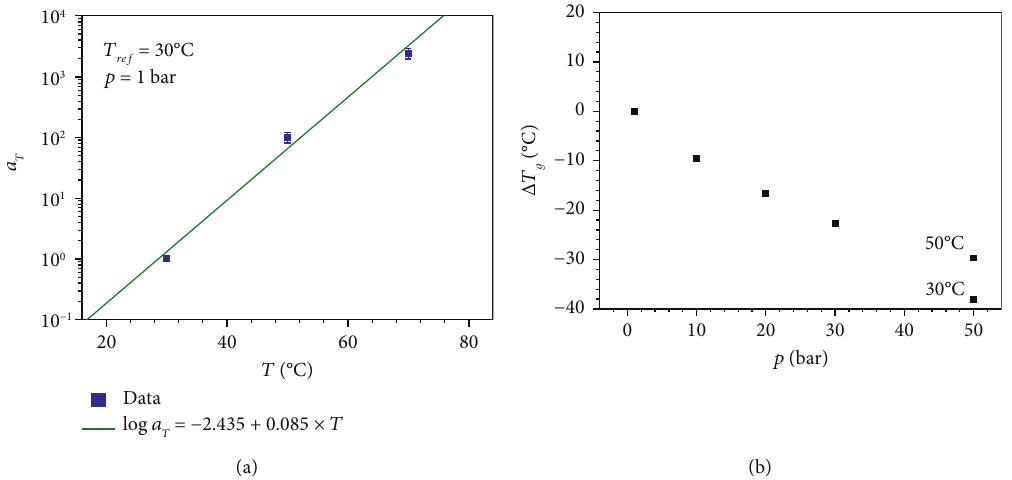
Figure 10: (a) Calculated shift factor a as obtained by tensile creep experiments at 30 ° C and ambient pressure. The result of a linear fi t to T the data is also plotted. (b) Glass transition temperature as a function of applied pressure as determined by analysis of the tensile creep compliance and of DSC experiments.